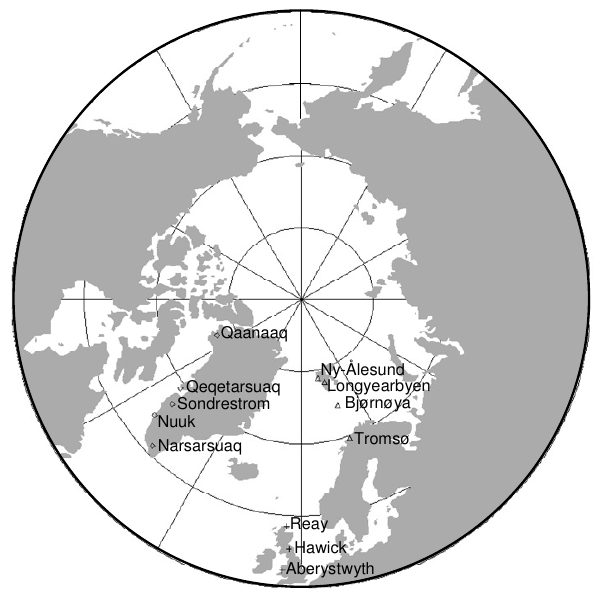
Fig. 1. Map showing the locations of the radio receivers of the tomography chains in Scandinavia, UK and Greenland.